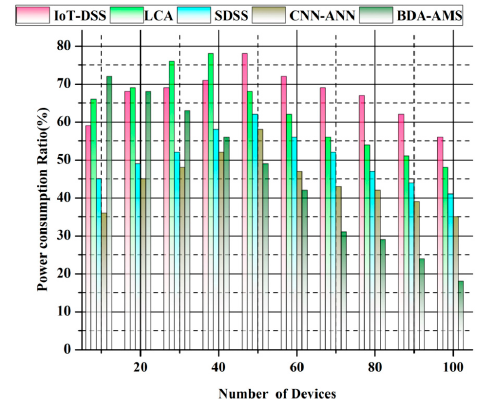
Figure 13. Power consumption ratio (%).